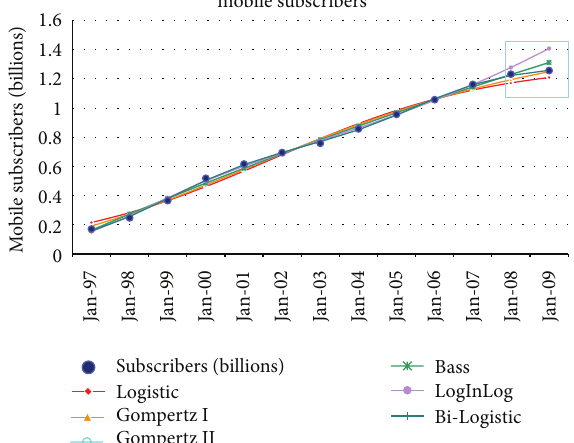
Table 6: Initialization parameters of modified-hGP.